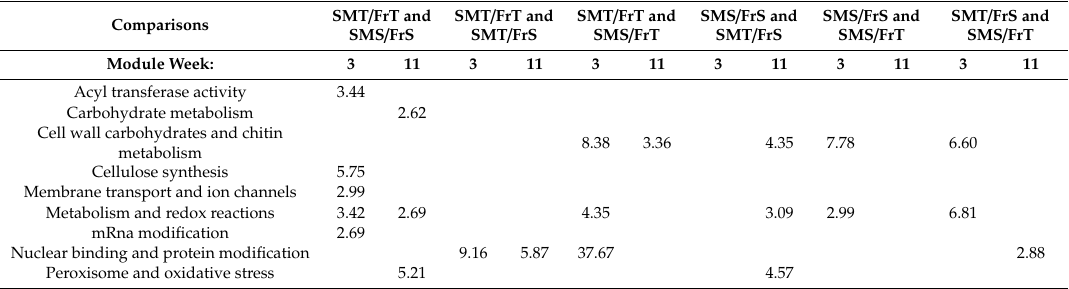
Table 2. Group enrichment score for putative modules related to molecular pathways di ff erentially regulated between wheat RILs with di ff ering levels of snow mold and freezing tolerance at the same time point. ( p -value significant at α =